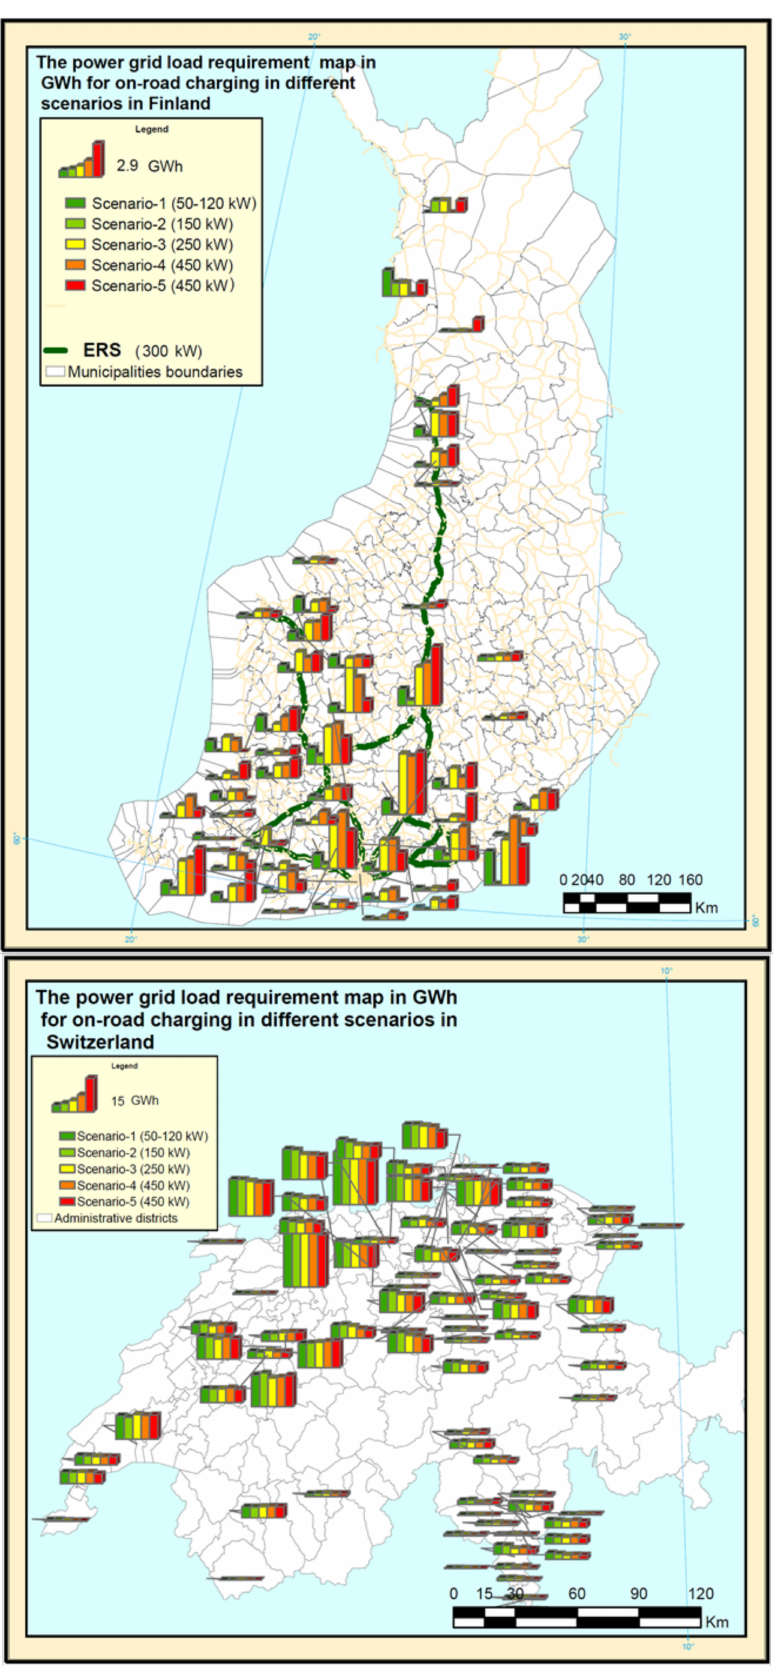
Figure 8. Annual power grid load requirement maps for on-road charging facilities in Finland and